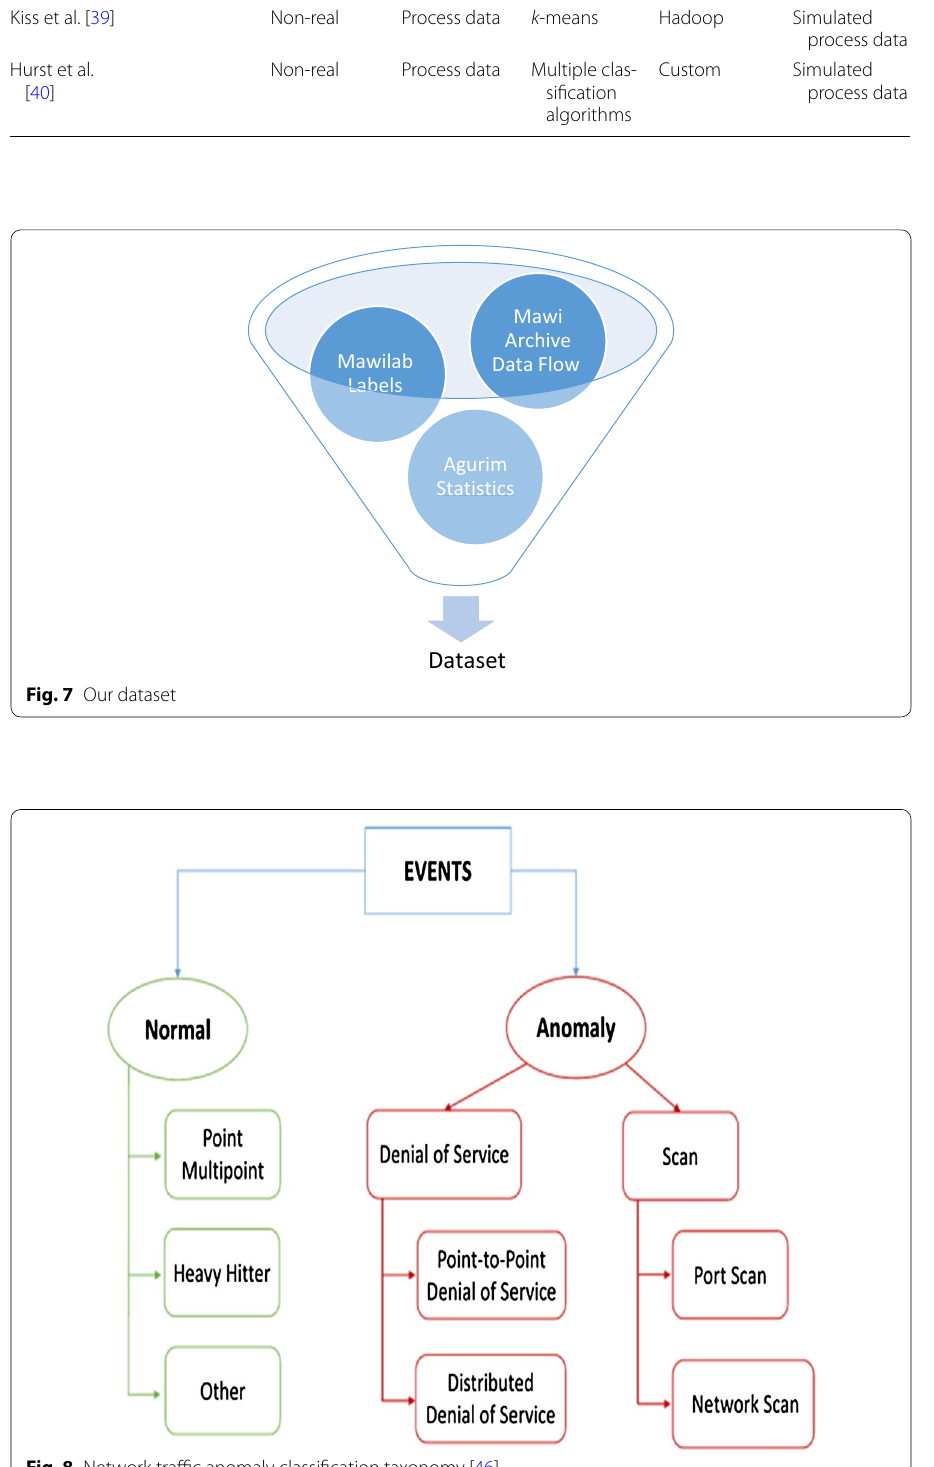
Fig. 8 Network traffic anomaly classification taxonomy